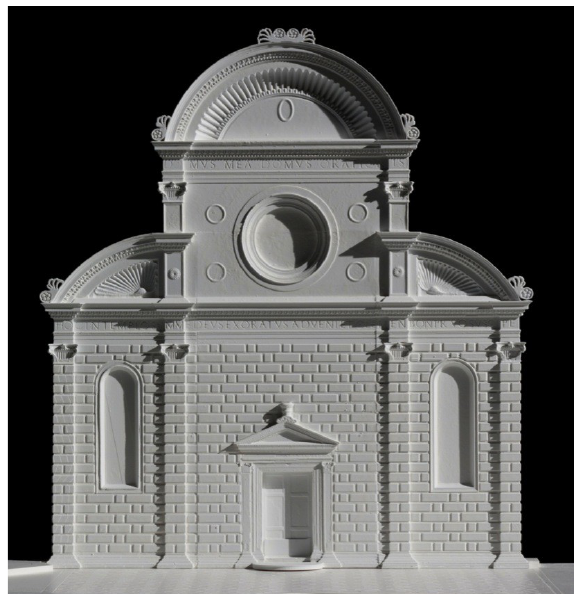
Figure 8. The final resin